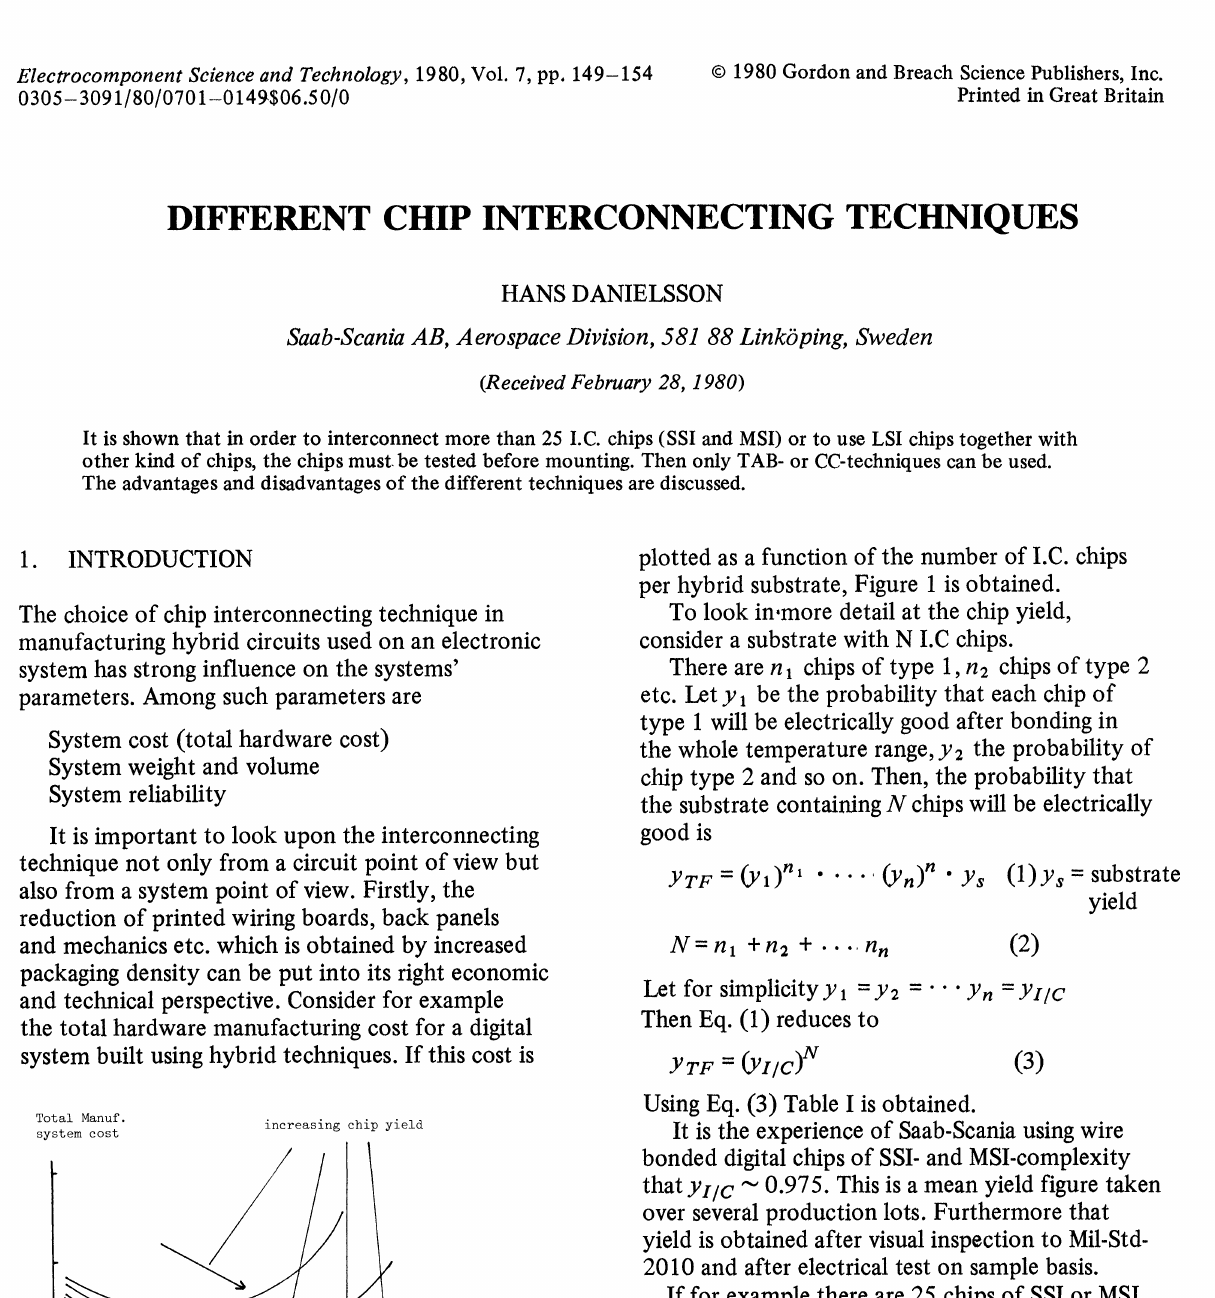
Number of I/C- chips per sub-